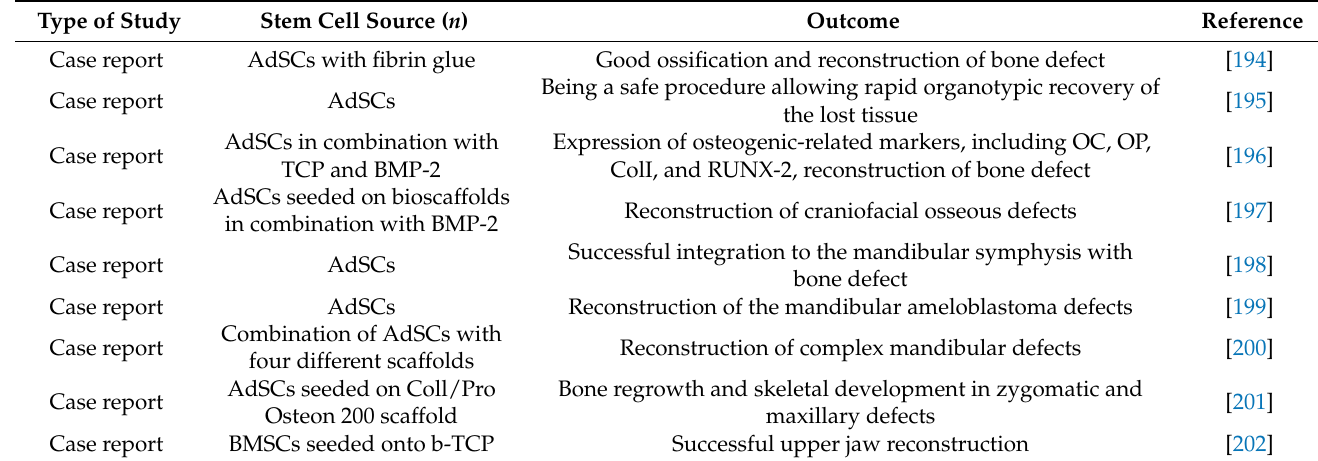
Table 9. Case reports regarding treatment of craniofacial defects and diseases using